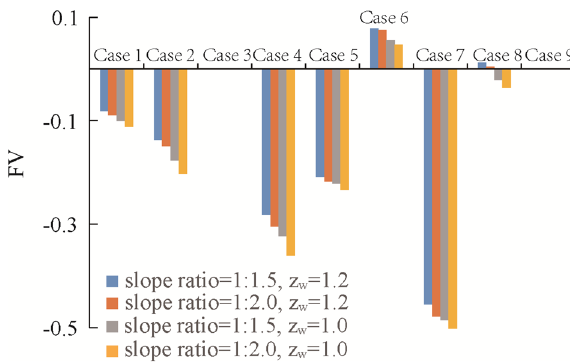
Figure 14. Comparison of FV under different